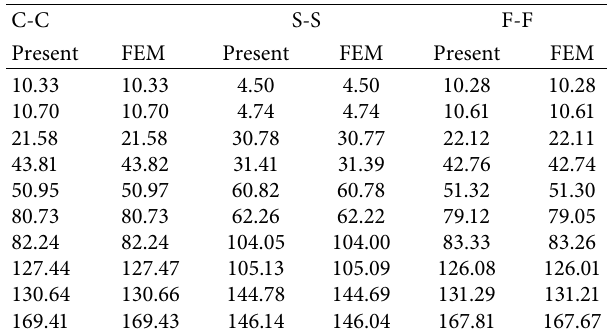
Table 7: Comparison of the first 10 natural frequencies of the S- shaped structure under different boundary conditions.